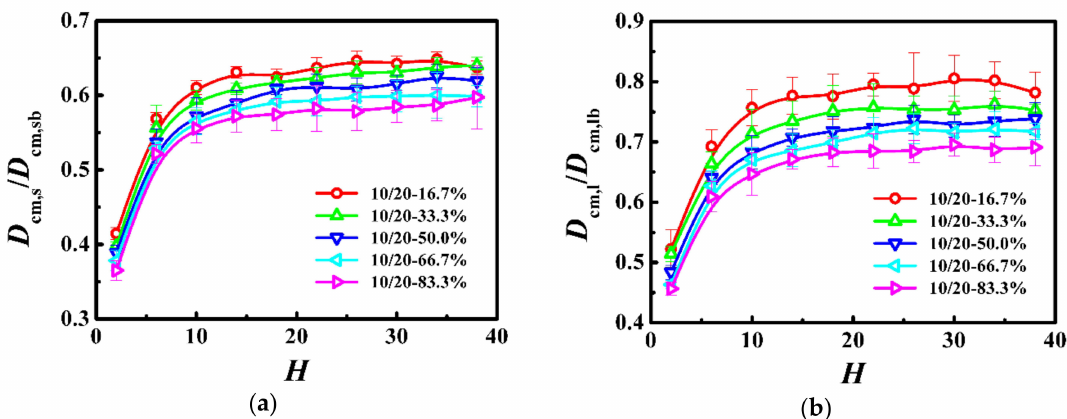
Figure 3. Normalized self-diffusion coefficient of the center-of-mass for ( a ) shorter ( D cm,s / D cm,sb ) and ( b ) longer ( D cm,l / D cm,lb ) chains as a function of the film thickness ( H ) in the model system of N s = 10 and N l =